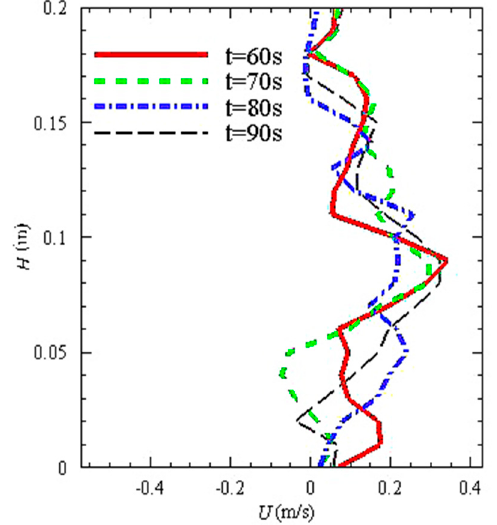
Figure 3. Comparison of flow velocities at inlet and outlet boundary at different times at t = 60.0 s, t = 70.0 s, t = 80.0 s and t = 90 s.